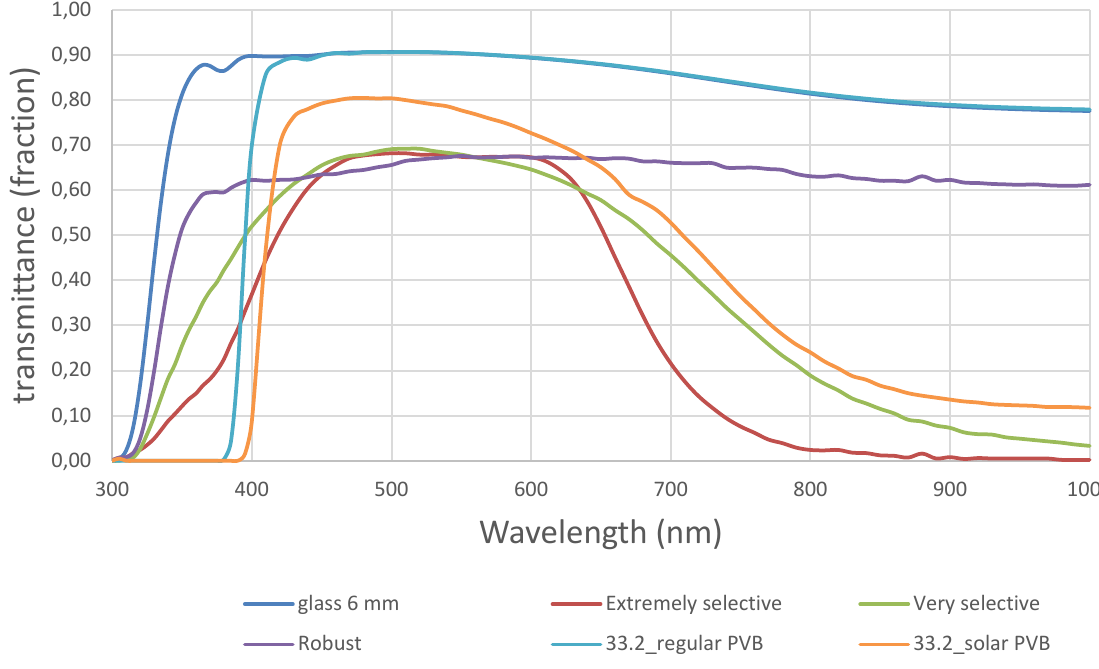
Fig. 1. Spectral performance of nominally 6 mm glass configurations as indicated (glass, SC coated glass (three coating types) laminated glass (two interlayer types), transmission